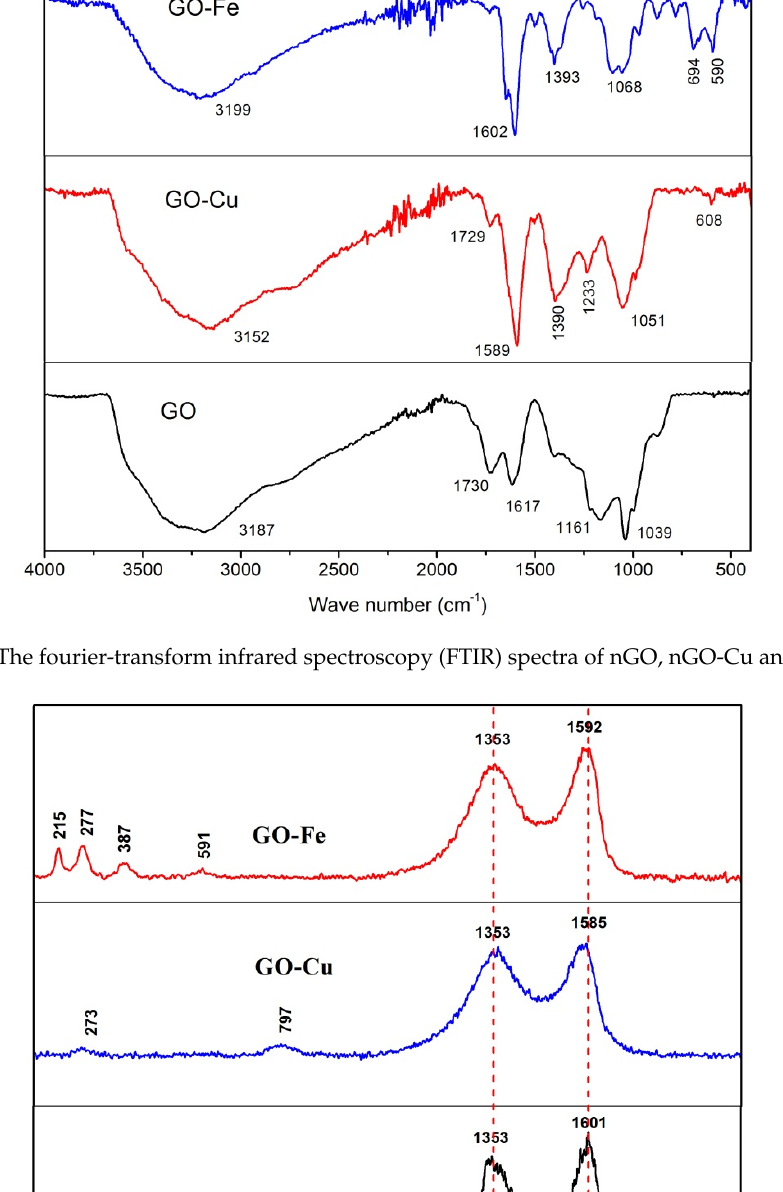
Figure 3. X-ray photoelectron spectroscopy ( XPS) binding energy spectra of ( a ) nGO-Fe, ( b ) nGO-Cu; ( c ) the Cu 2p spectra of nGO-Cu, without peak fitting; ( e ) the Fe 2p spectra of nGO-Fe, without peak fitting; the fitted C 1s peak curves for ( d ) nGO-Cu, and ( f ) nGO-Fe. Figure 4 shows the SEM images and Ehlers-Danlos syndrome (EDS) curves of nGO, nGO-Cu, and nGO-Fe. It can be seen from the EDS results that the content of Cu 2+ in nGO is lower than that of